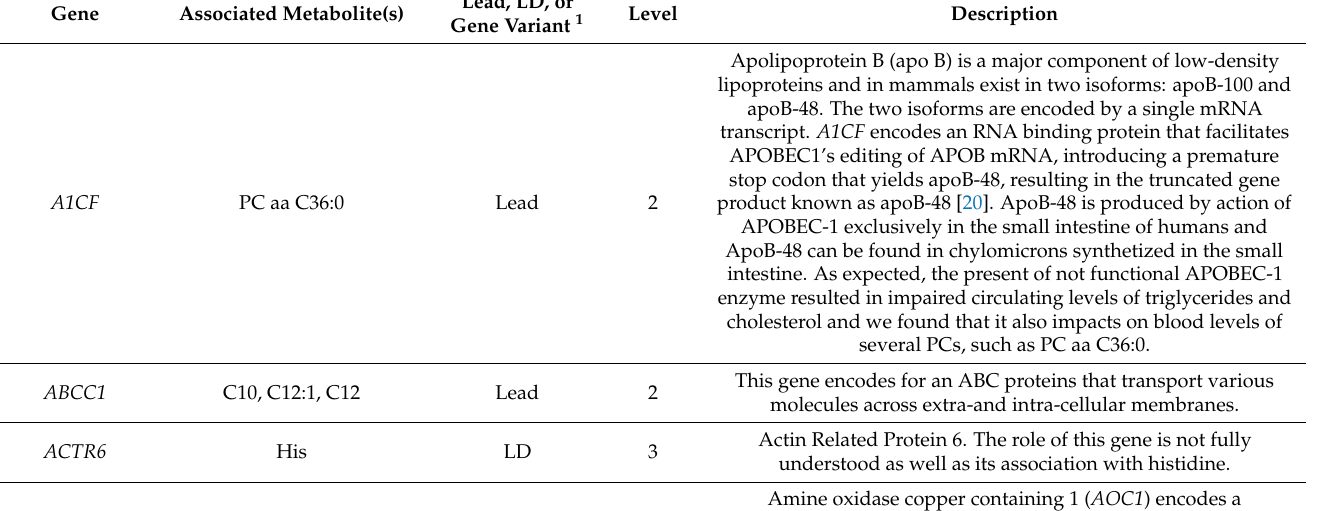
Table 2. Summary of genes identified in this